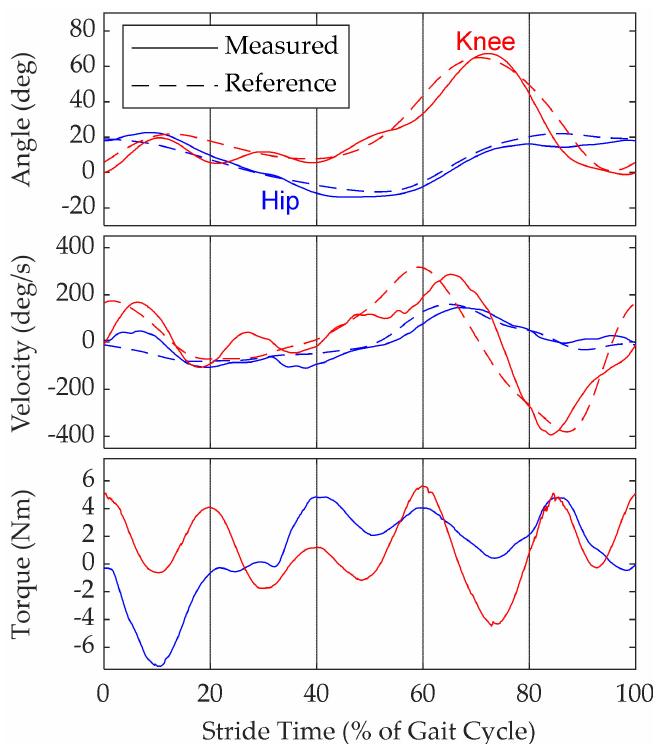
Figure 10. Experimental results for joint angle, velocity, and torque in gait tracking with the prototype orthosis and pediatric test dummy using state-feedback